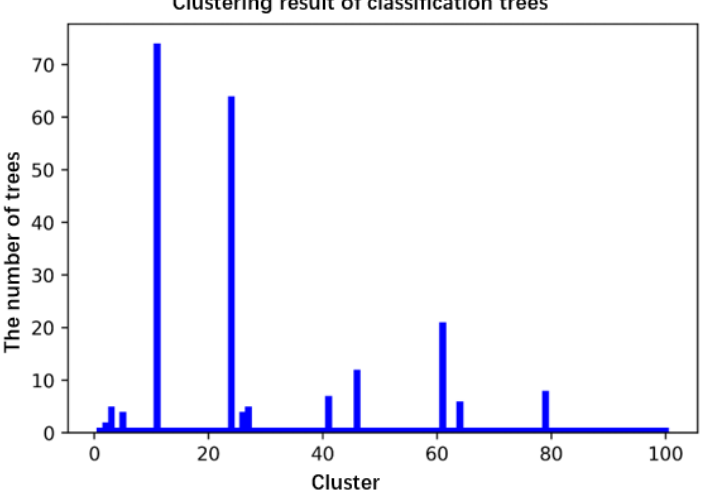
Figure 9. Clustering result for classification trees.